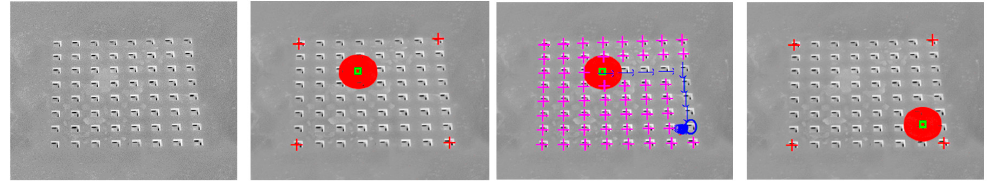
Figure 20. The four main conveyance steps (from left to right): capture of the surface without an object; capture of the surface with an object—image processing and object detection; detection of the desired final position and trajectory calculation; object on the final position.